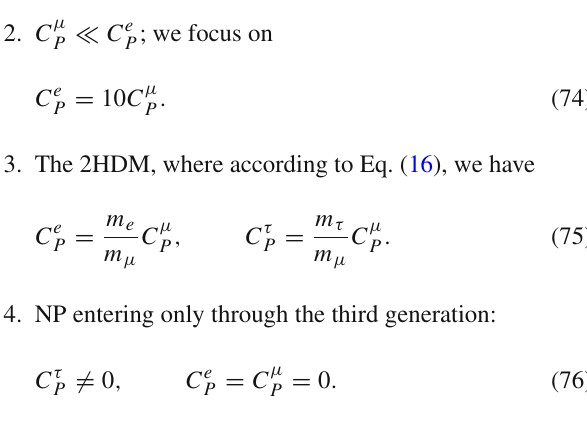
(cid:27) B ( ¯ B → ρ(cid:2) − ¯ ν (cid:2) )